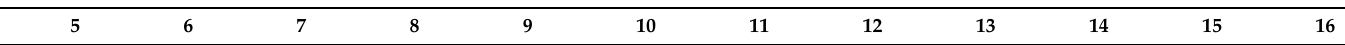
Table 2. Correlation